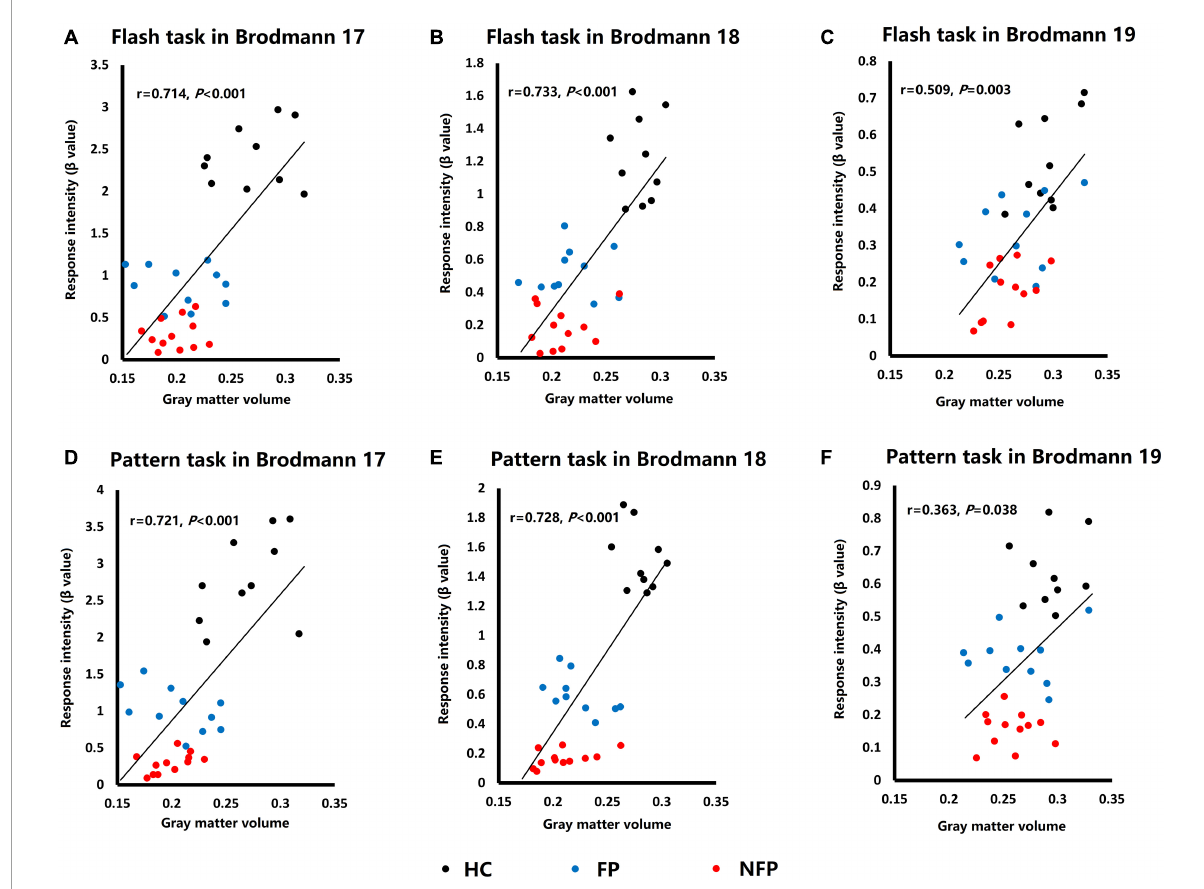
FIGURE6 Plots of the correlation analysis of response intensity in visual tasks and GMVs of Brodmann areas 17, 18, and 19. (A) Correlation analysis of data obtained from Brodmann area 17 in response to the flash stimulus. (B) Correlation analysis of data obtained from Brodmann area 18 in response to the flash stimulus. (C) Correlation analysis of data obtained from Brodmann area 19 in response to the flash stimulus. (D) Correlation analysis of data obtained from Brodmann area 17 in response to the pattern stimulus. (E) Correlation analysis of data obtained from Brodmann area 18 in response to the pattern stimulus. (F) Correlation analysis of data obtained from Brodmann area 19 in response to the pattern stimulus. HC, healthy control; FP, form perception; NFP, no form perception; VC, visual cortex; SPL, superior parietal lobule; ITG, inferior temporal gyrus; FEF, frontal eye field. Black dots: HC subjects, blue dots: FP patients, and red dots: NFP